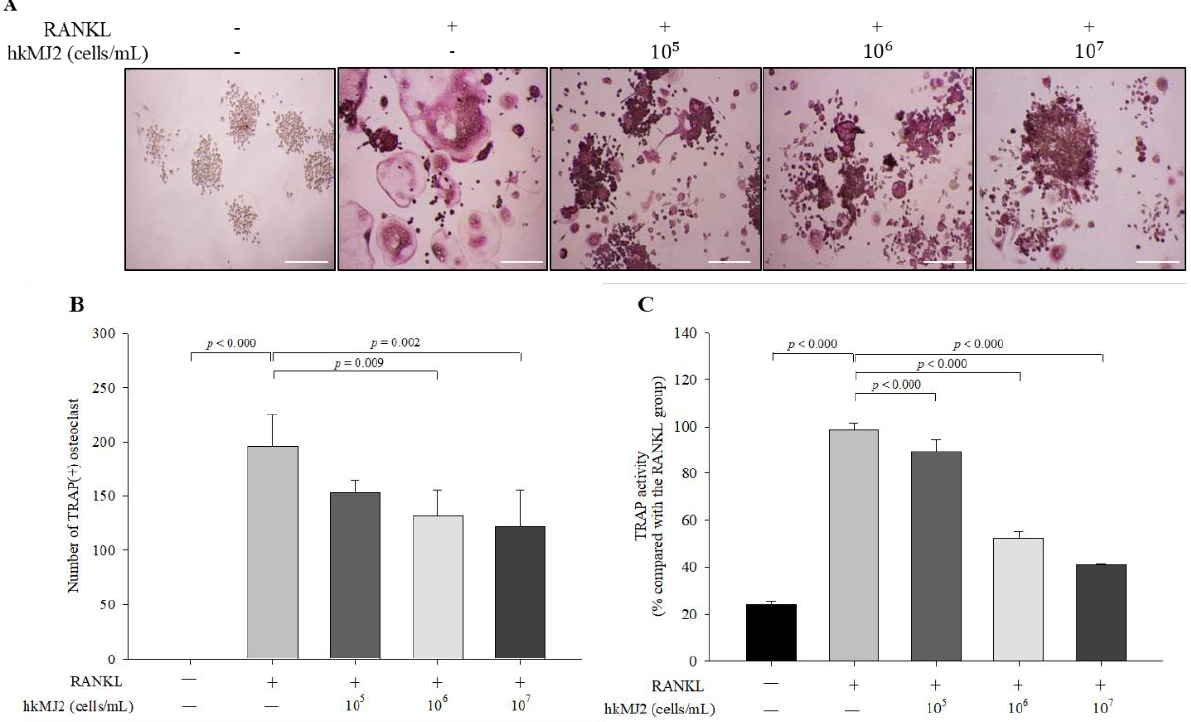
Figure 2. Effect of hkMJ2 on TRAP(+) number and TRAP activity. RANKL-induced osteoclast formation was measured by TRAP staining ( A ) (100×, scale bar = 100 μm), and the number of TRAP(+) multinucleated osteoclasts were counted ( B ), and TRAP activity was quantified ( C ). The values indicate the mean ± standard deviation (SD) of three independent experiments performed in triplicate. RANKL, receptor activator of the nuclear factor- κB ligand; TRAP, tartrate-resistant acid phosphatase. − , no addition; +, addition. One-way ANOVA followed by Tukey’s HSD was used to determine significance.